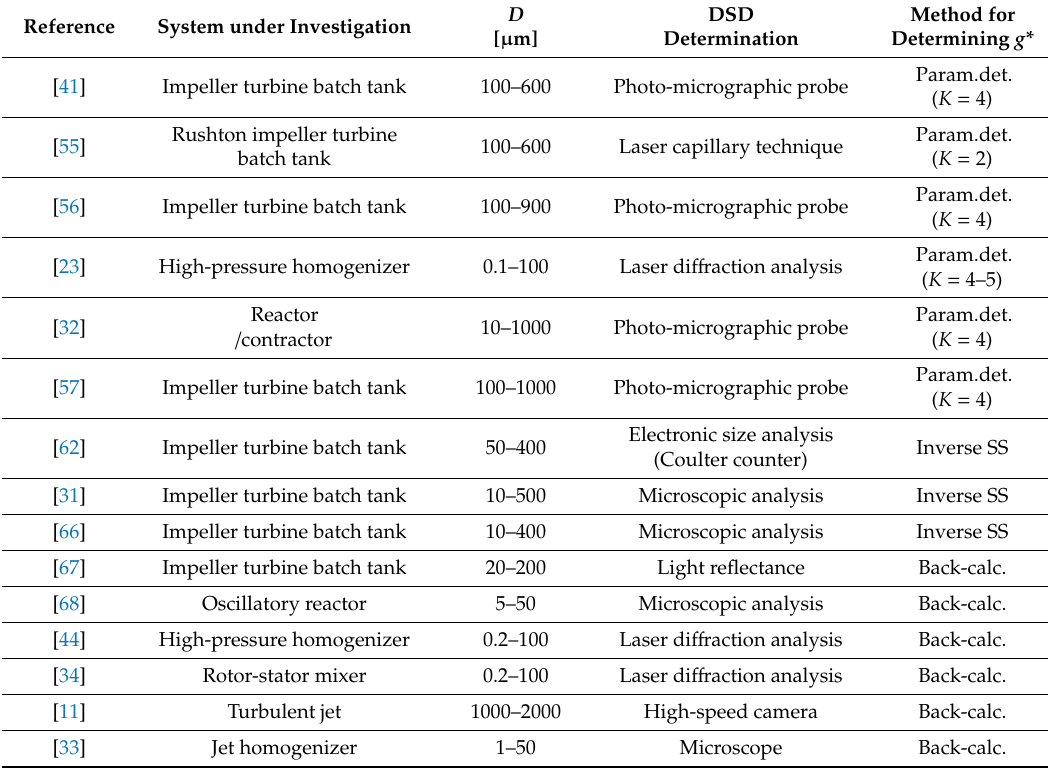
Table 3. Comparison of the studies determining the breakup frequency from an emulsification